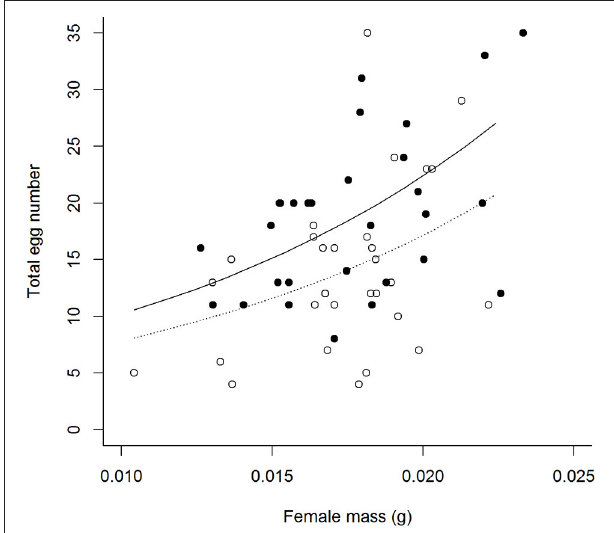
FIGURE 1 | Total number of eggs laid by females under differing perceived predation risk environments [ ◦ = no predation risk (P − ), • = predation risk (P + )], by female mass (mg) at the experimental start point. Plotted lines are estimates from